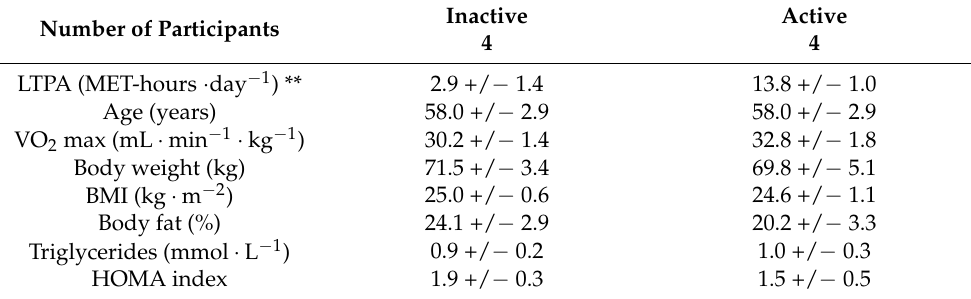
Table 1. Characteristics of twin pairs. Mean ± SEM. ** p < 0.001 with t -test.